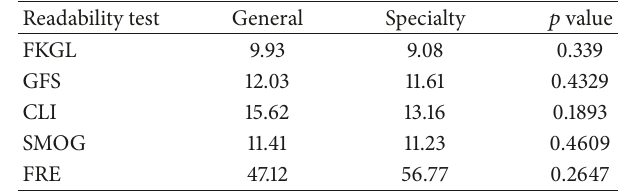
Table 5: Mean readability scores of general medical websites as compared with specialty